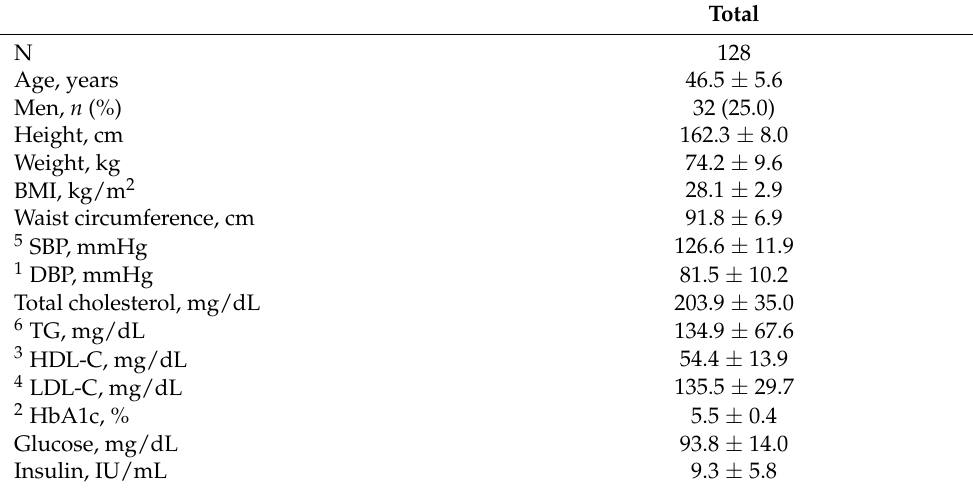
Table 1. Baseline characteristics of study subjects before the